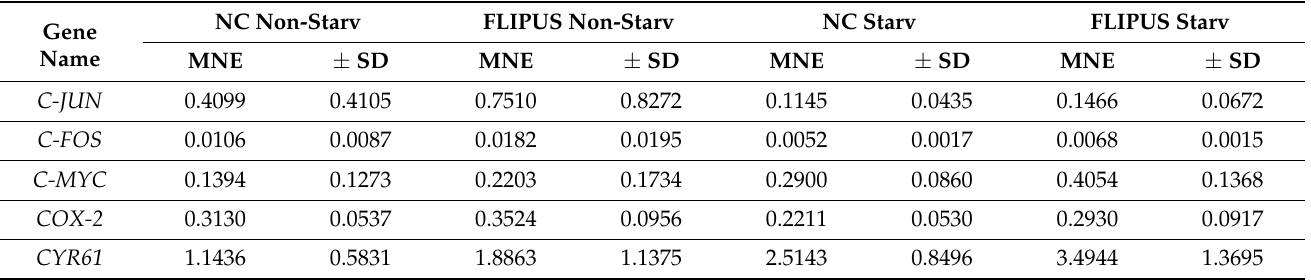
Table A1. Absolute mean normalized expression (MNE) values of early response genes after 10 min FLIPUS stimulation.